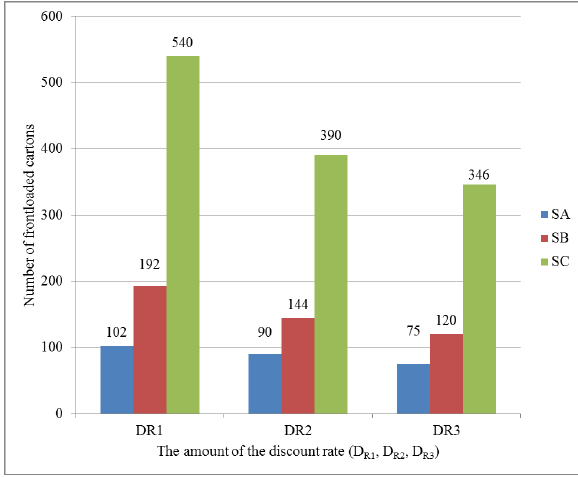
Figure 3: Types of frontloading below the type of store and the dis- count rate ( D R 1 , D R 2 , D R 3 )